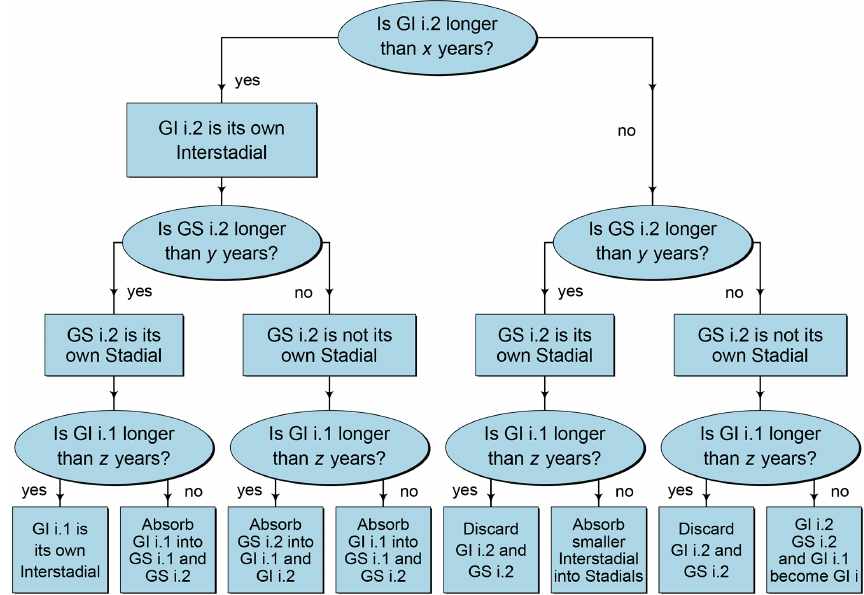
Figure 2. Decision tree for determining which warm–cold intervals split up by the INTIMATE stratigraphy can confidently be considered their own unique D–O events. Given the variety of climatic shifts present in the high-resolution INTIMATE NGRIP δ 18 O stratigraphy, it is necessary to form a rigorous criterion for choosing D–O events to analyze. Since the duration of each D–O event in the INTIMATE stratigraphy is directly tied to the confidence that it exhibits the true characteristics of a D–O interstadial (stadial) period, we employ the above duration-based scheme with flexible parameters ( x,y,z ) in order to determine which D–O cycles to include in this analysis. Table 1. Three different stadial choice situations for different duration parameter choices in Fig. 2. The choice results in the first column (( x,y,z ) = (300 , 300 , 200)) represent our preferred choices for statistical analysis. Note that basing the analysis on the stratigraphic choices represented in the second or third columns yields 86%–93% similarity in